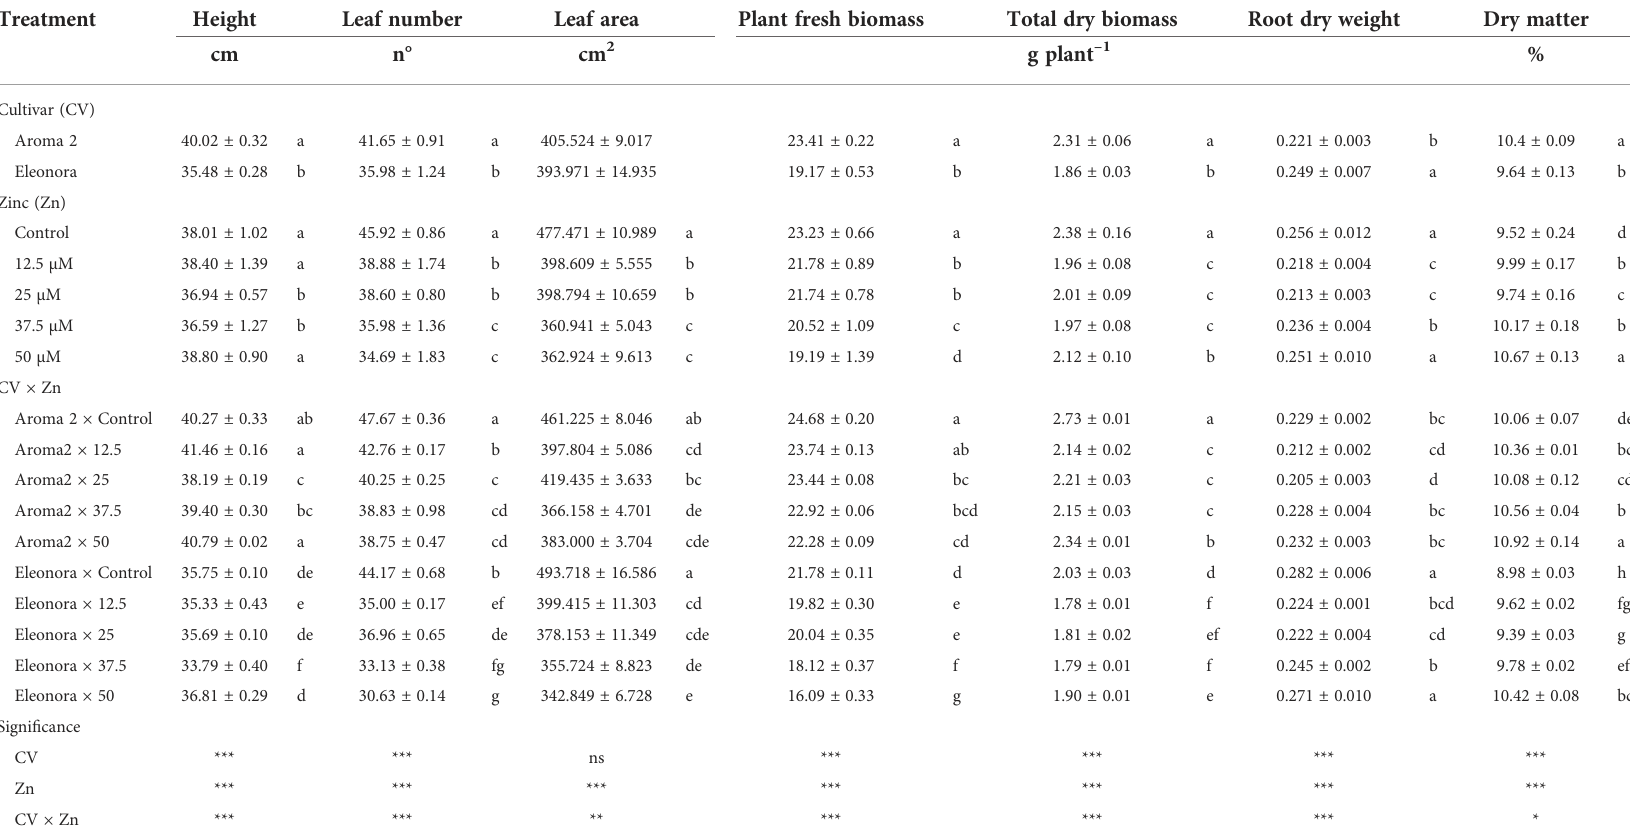
TABLE 1 Analysis of variance and mean comparisons for height, leaf number, leaf area, plant fresh biomass, total dry biomass, root dry weight, and dry matter of Aroma 2 and Eleonora basil cultivars grown hydroponically under different Zn treatments: 0 = Control; 12.5; 25; 37.5; 50 µmol of